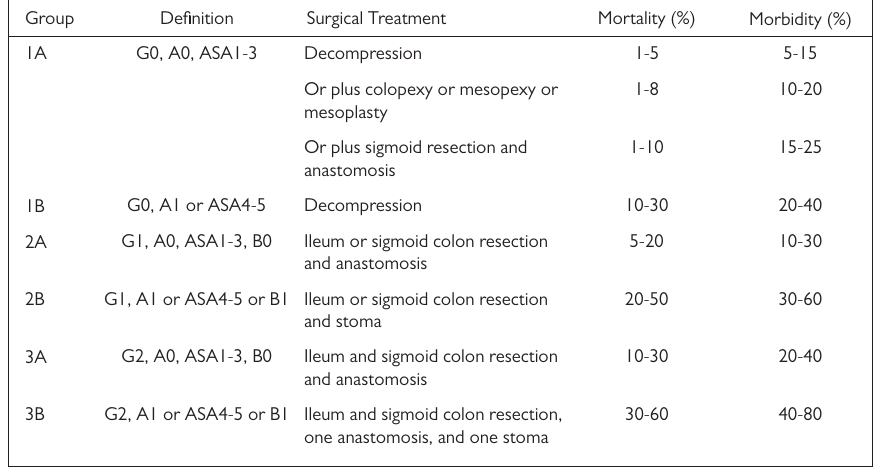
Table 2. Classification of Ileosigmoid Knotting by Atamanalp